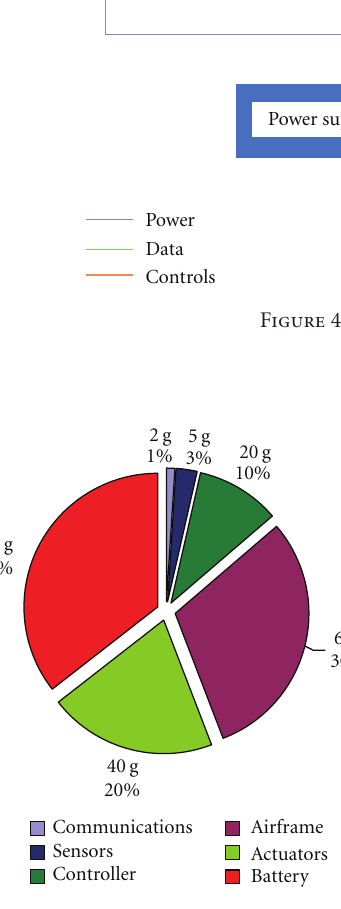
Figure 5: Weight budget for 197g AVS as presented in [15]. rotary wings, and flapping wings. The fourth class is without propulsion and is called passive.